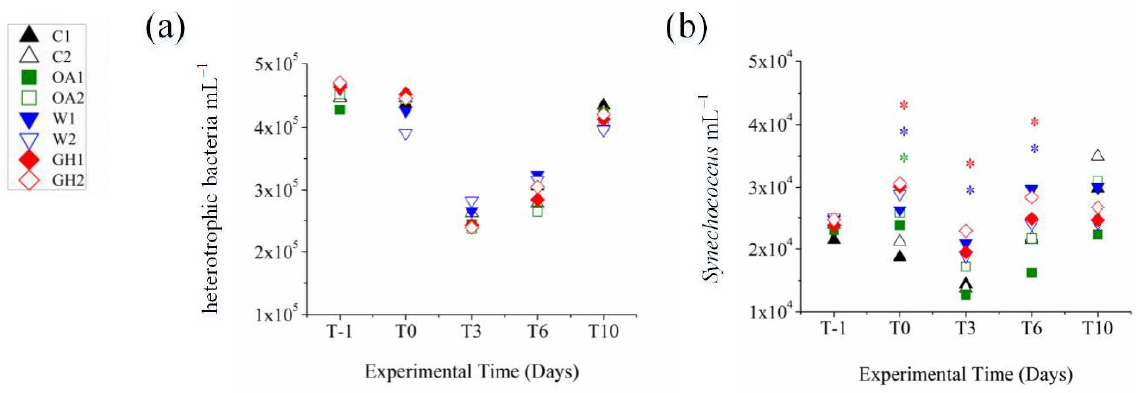
Figure 2. Percentage contribution of bacterial phyla (>0.2 µ m fraction) in the mesocosms at T–1, T0, T3, T6 and T10. “Other” phyla include Acidobacteria, Chlorobi, Chloroflexi, Firmicutes, Gemmatimonadetes, NC10, Nitrospirae, Spirochaetes and ZB3. C: control mesocosms, W: mesocosms where the temperature was increased by 3 ◦ C (labeled after warming), OA: mesocosms where the pH was decreased by 0.3 units (labeled after ocean acidification), GH: mesocosms where the temperature was increased by 3 ◦ C and the pH was decreased by 0.3 units (labeled after